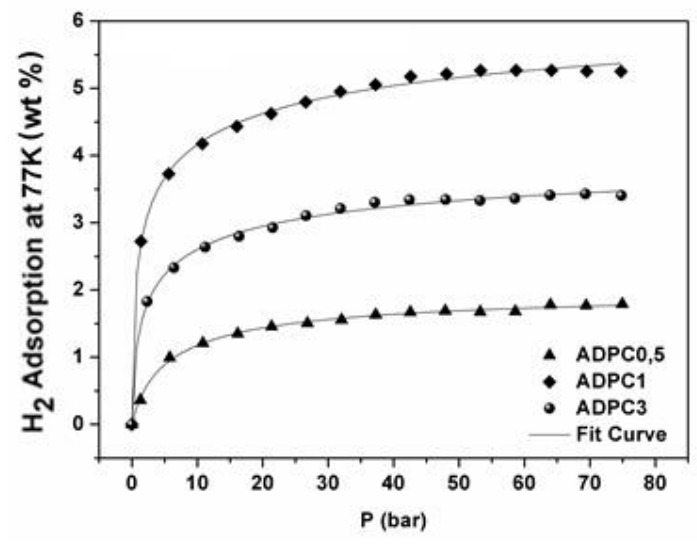
Figure 9. H 2 adsorption isotherms at 77 K up to 80 bar. The magnitude of the error is the size of the symbol itself. Solid lines represent fits to the Töth equation.